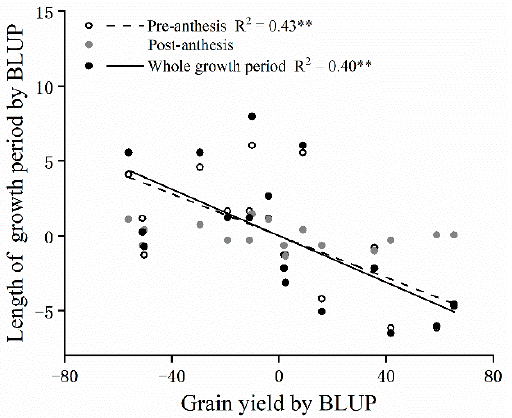
Figure 3. The relationships between grain yield by BLUP and length of pre-anthesis period by BLUP, length of post-anthesis period by BLUP, and length of the entire growth period by BLUP. Only the significant linear regressions are shown. ** p < 0.01.